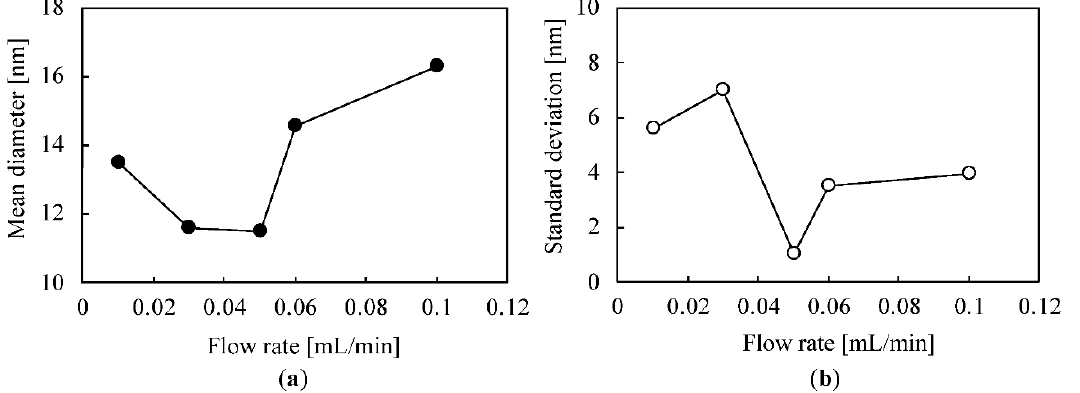
Figure 5. ( a ) Mean diameter and ( b ) standard deviation as a function of the flow